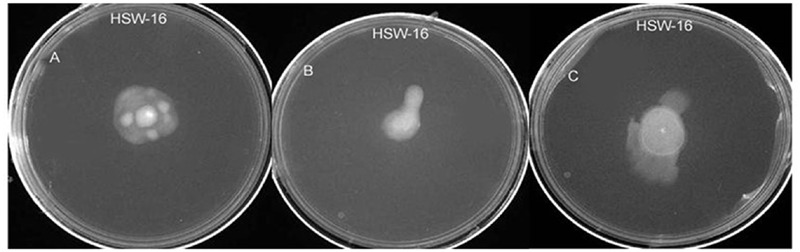
Test of various types of motility in B. licheniformis HSW-16 using agar-based method. (A–C) Represent swimming, swarming, and twitching, respectively.